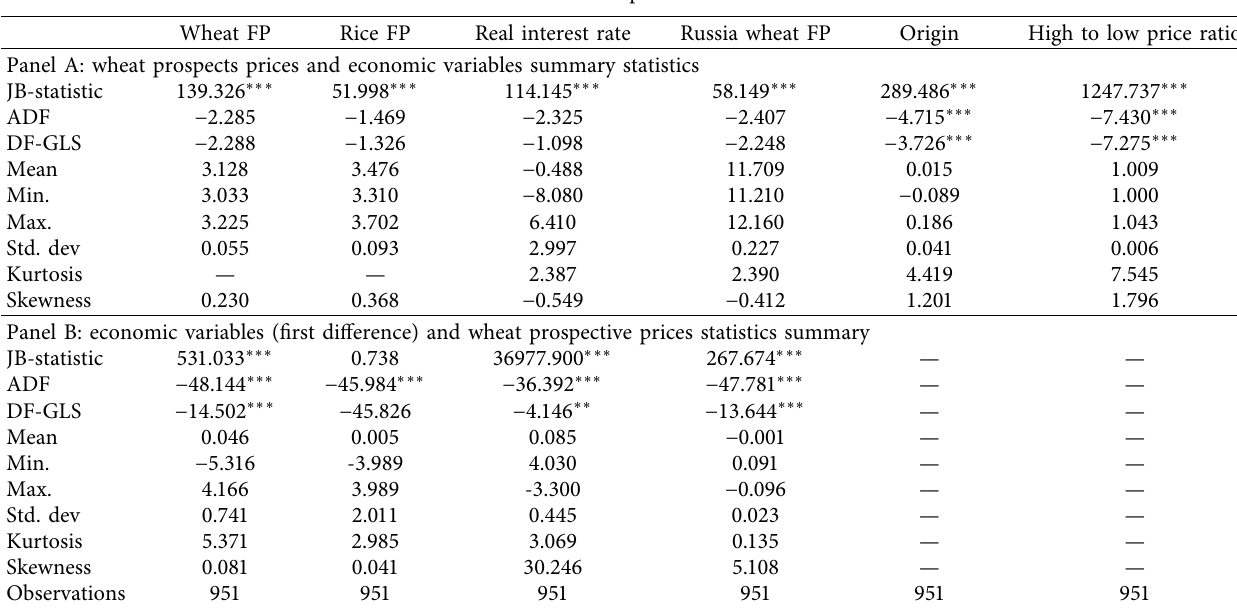
Table 2: Descriptive statistics.